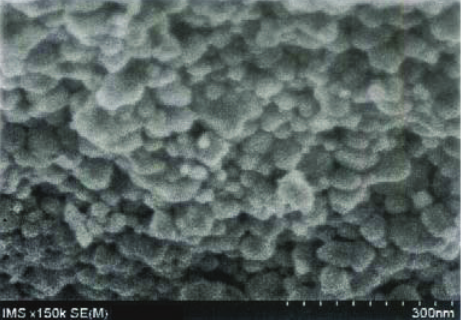
Figure 8: SEM micrograph of nano-LaFeO 3 prepared by high- energy milling method.